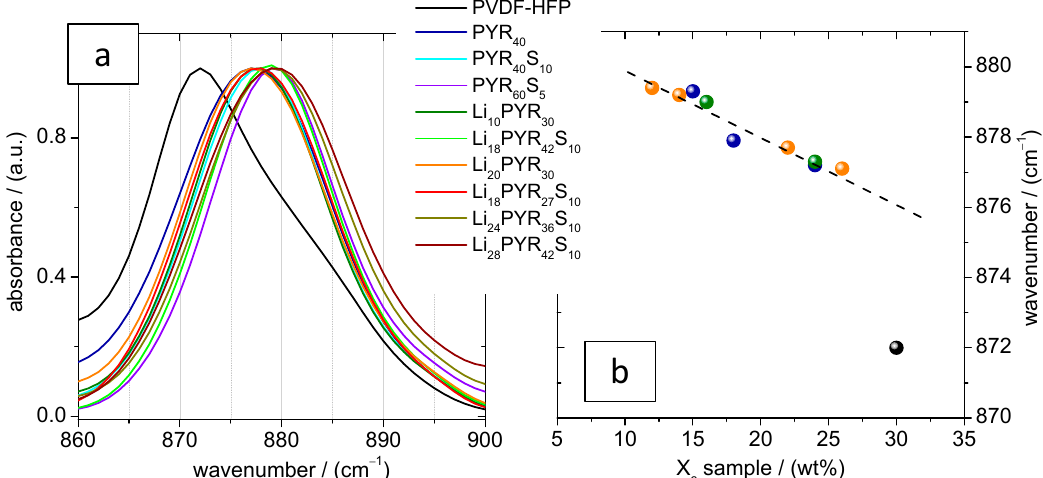
Figure 4. ( a ) The normalized PVDF–HFP 872 cm − 1 band in the copolymer and its progressive shifting in all the electrolytes and ( b ) shift of the 872 cm − 1 band towards 880 cm − 1 with increasing crystalline fraction in the whole sample (X c sample).